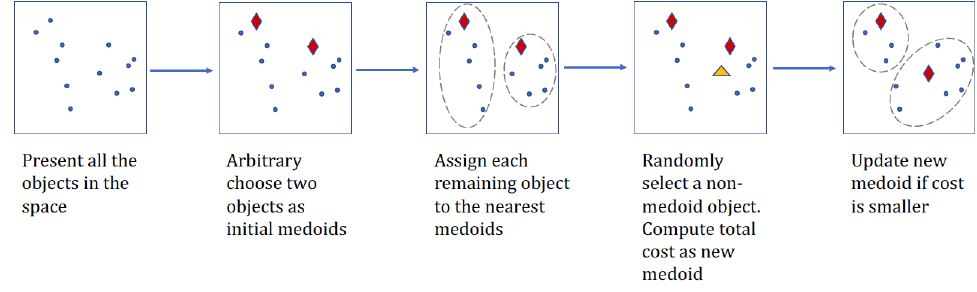
Figure 1. A flowchart to illustrate PAM algorithm for two clusters. Algorithm 1: for clustering based on joint mixture